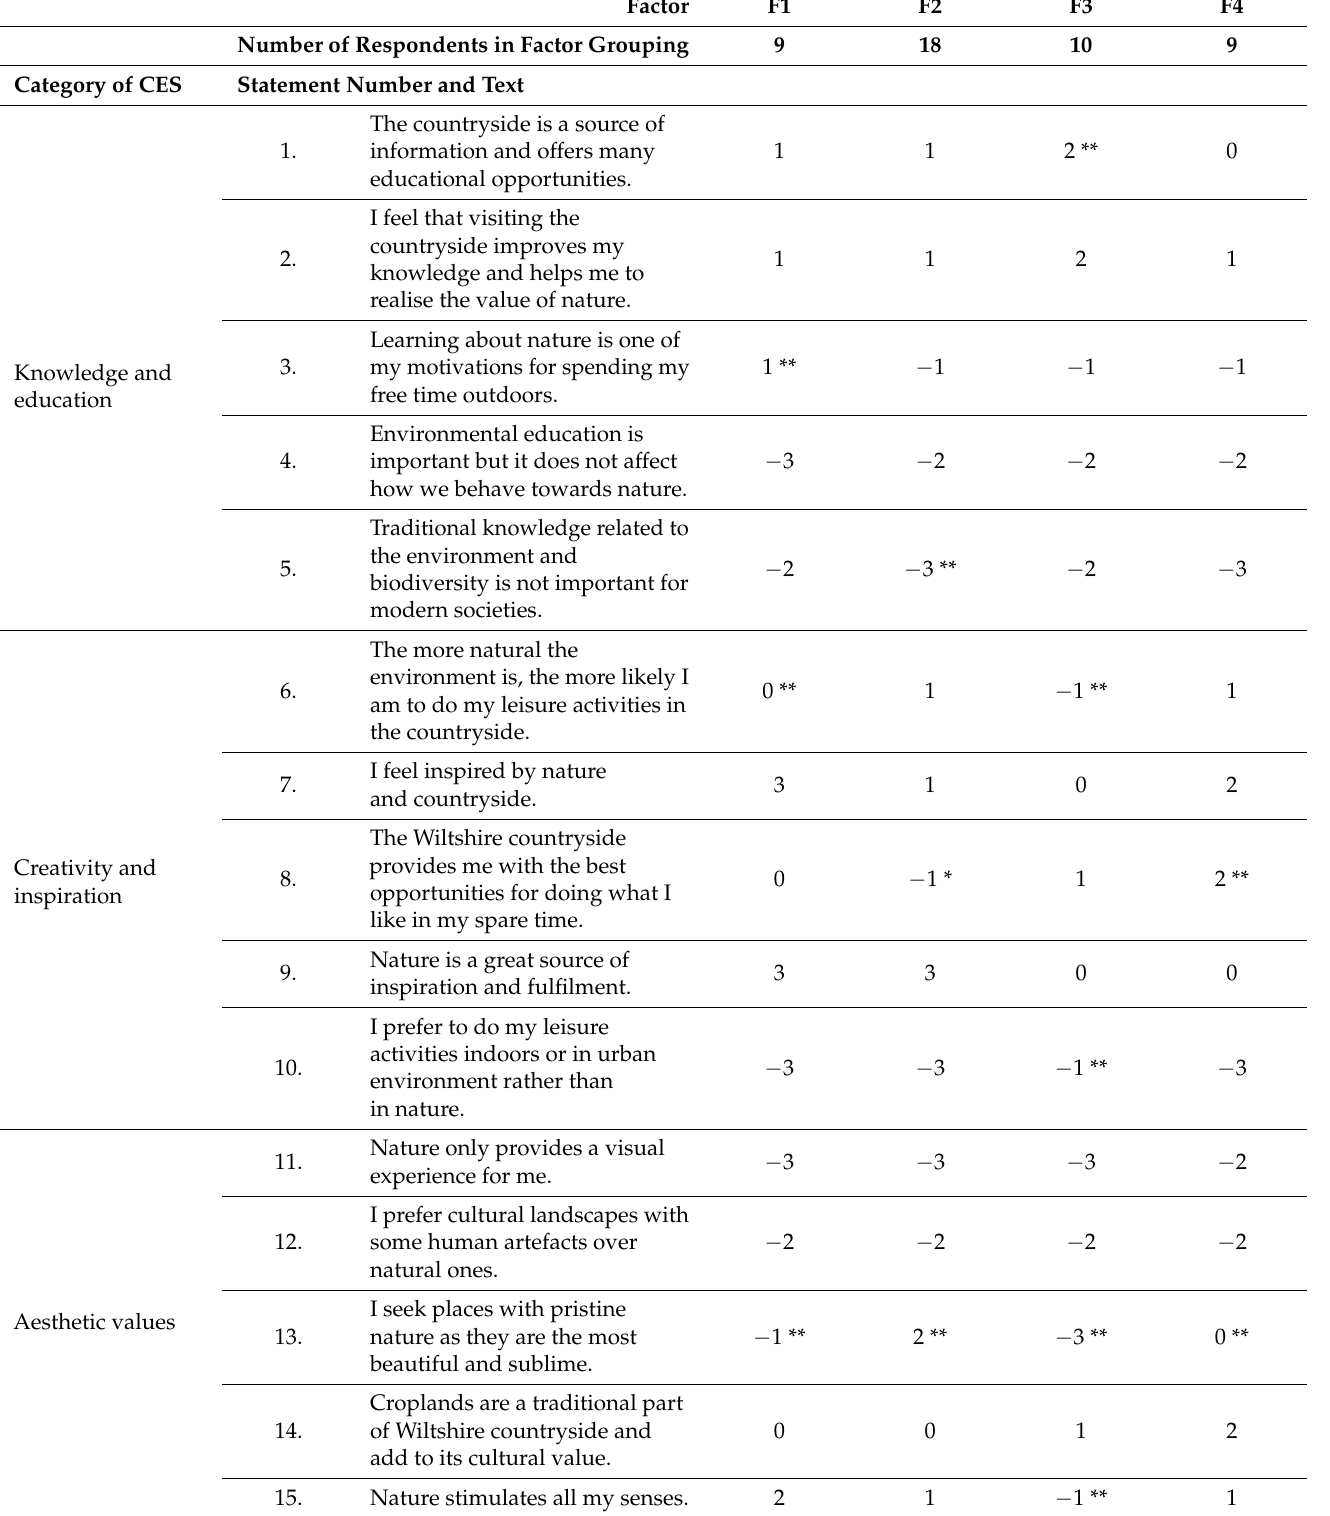
Table 2. Statements, categories, factor Q-sort values for each